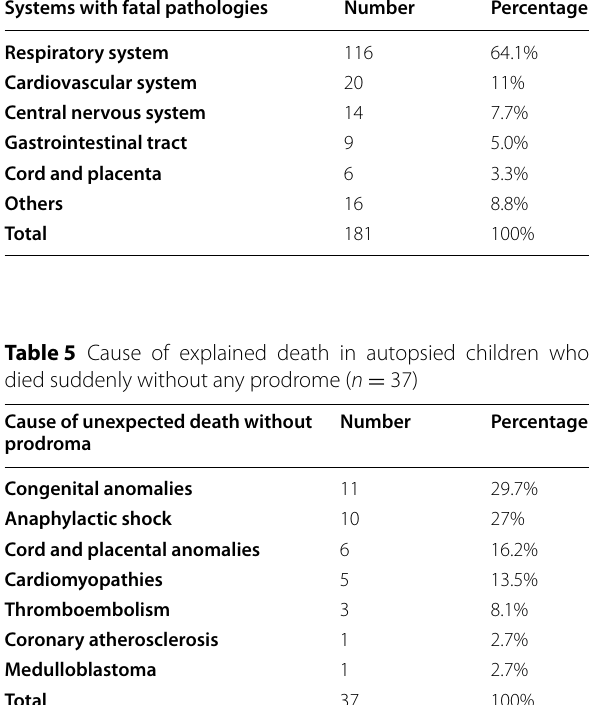
Table 4 Different body systems with fatal pathologies in explained deaths ( n 181) =